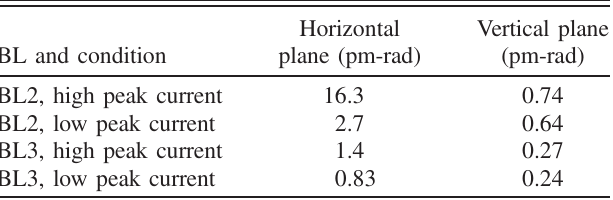
TABLE I. Measured stability of the injection orbit to the undulators. Both position and angle were measured and the area (rms) of distribution in the phase space was calculated for the horizontal and vertical planes. The electron bunch profiles for the high and low peak currents are shown in Fig. 7. The beam energy was 7.8